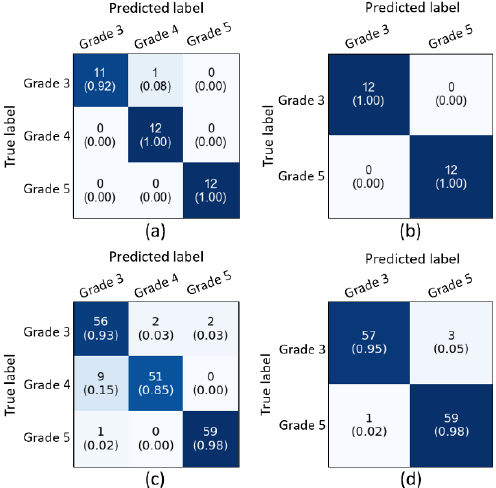
Figure 9. Confusion matrices of the supervised and unsupervised classification using test and whole datasets, respectively. ( a , b ) Confusion matrices of multiclass and binary classification using supervised ensemble technique based upon the test split 1 and 2 in Table 3a, respectively. ( c , d ) Confusion matrices of multiclass and binary classification using an unsupervised technique based upon the data split 2, respectively.